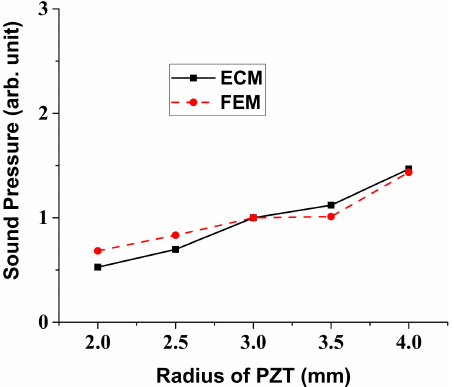
Figure 9. Effect of the PZT radius variation on the radiated sound